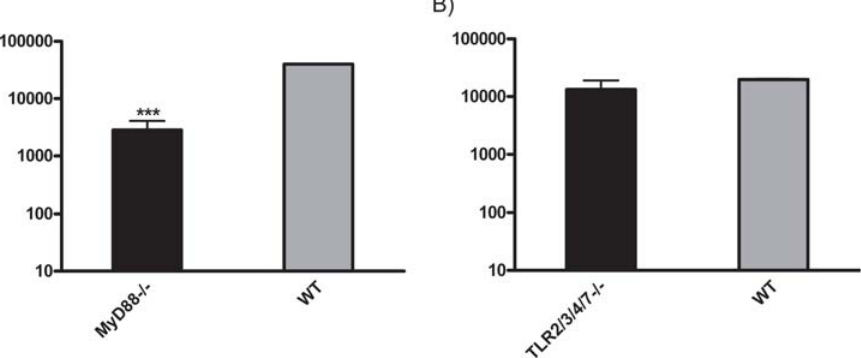
Figure 4. CAF01-induced responses in TLR2, 3, 4, 7 and MyD88-deficient mice. A) MyD88-/- and B) TLR2, 3, 4, 7-/- mice as well as WT controls mice (n=3) were vaccinated twice with 2 m g of Ag85B-ESAT-6 in CAF01 by footpad immunization. Two weeks after the last immunization, the inguinal lymphnodes were harvested and restimulated in vitro with 10 m g of Ag85B-ESAT-6. The release of IFN- c was determined by ELISA.